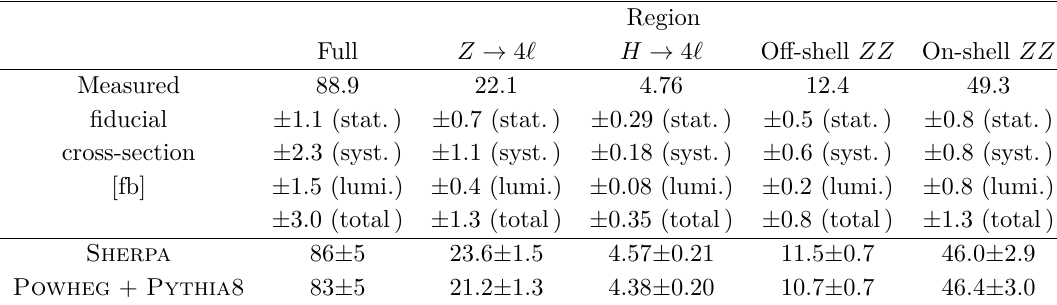
Table 2 . Fiducial cross-sections in fb in the full fiducial phase space and in the following regions of m : Z → 4 ‘ ( 60 < m 100 GeV), H → 4 ‘ ( 120 < m 130 GeV), off-shell ZZ ( 20 < 4 ‘ 4 ‘ < 4 ‘ < m 4 ‘ < 60 GeV or 100 < m 4 ‘ < 120 GeV or 130 < m 4 ‘ < 180 GeV) and on-shell ZZ ( 180 < m 4 ‘ < 2000 GeV), compared with particle-level predictions and their uncertainties as described in section 4. Two predictions are shown for the q ¯ q → 4 ‘ process simulated with Sherpa or